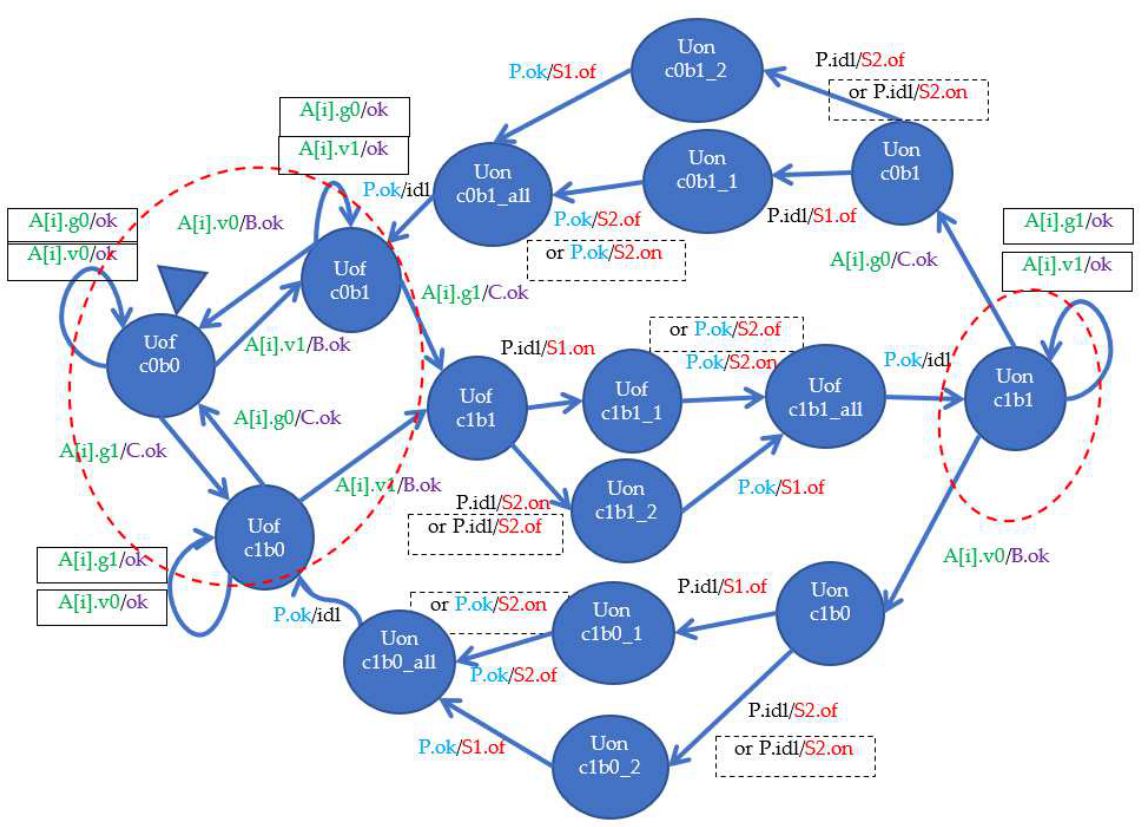
Figure 7. Coil model.